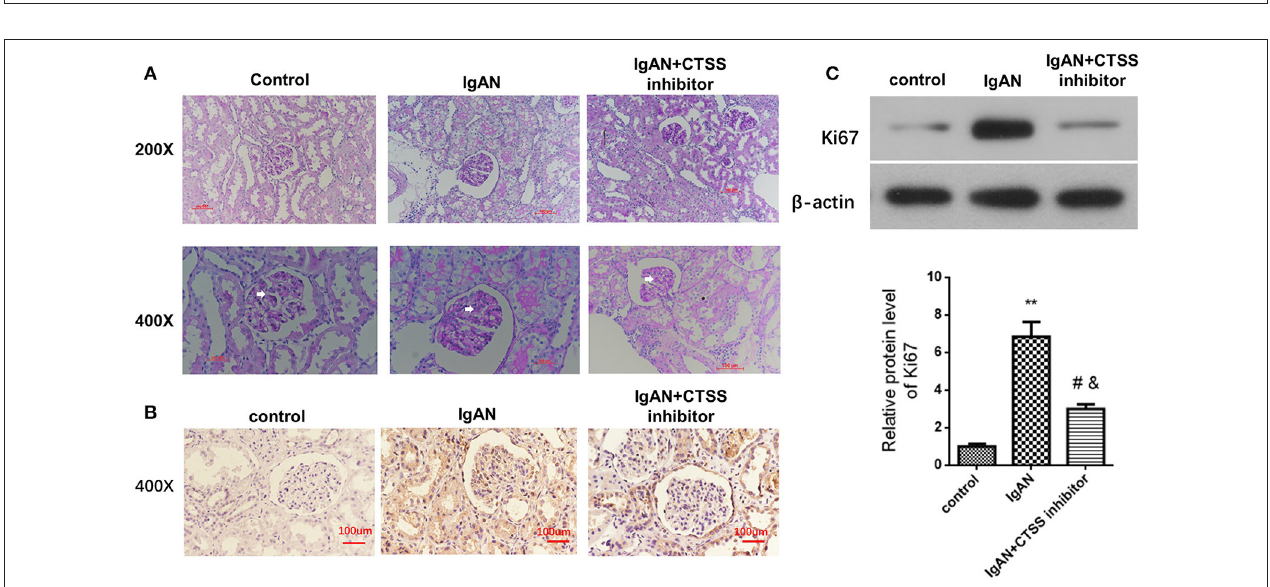
FIGURE 4 | Treatment with a CTSS inhibitor reduces mesangial cell proliferation in IgAN rats. Following induction of IgAN and treatment with the CTSS inhibitor in rats, the pathological changes in the kidney tissues from the experimental and control groups of rats were analyzed PAS staining. The relative levels of Ki67 expression in renal tissues of each group of rats were determined by immunohistochemistry and Western blotting assays. Data are representative images or expressed as the means ± SD of each group ( n = 10 per group) from three separate experiments. (A) PAS staining analysis of the kidney sections. (B) Immunohistochemistry analysis of Ki67 protein expression in kidney tissues. (C) Western blot analysis of the relative levels of Ki67 expression in the renal tissues ** P < 0.01 vs. the Controls; # P < 0.05 vs. the IgAN group; & P < 0.05 vs. the Controls.